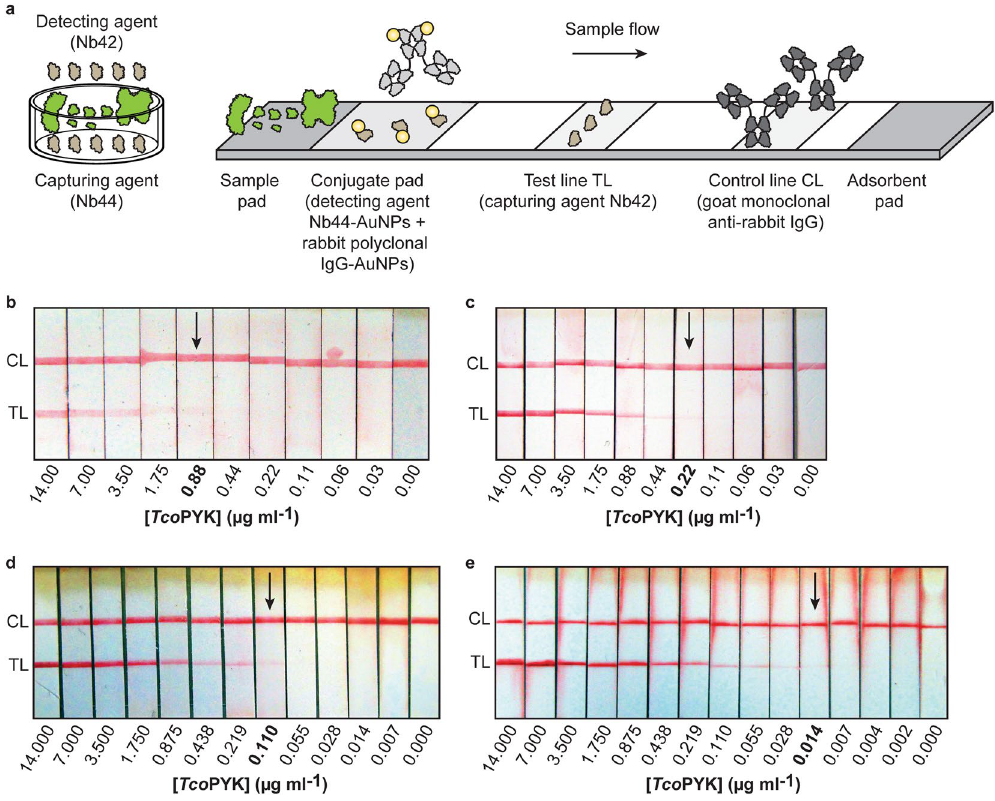
Figure 5. Generation of a Nb-based LFA for detection of T . congolense . ( a ) Schematic representation of the Nb44/Nb42 sandwich ELISA (left panel) and Nb44/Nb42 LFA (right panel). In both panels, the T . congolense antigens are coloured in green, while the Nbs are shown in brown. IgGs are displayed in light (rabbit polyclonal) and dark (goat monoclonal) grey. The AuNPs are shown as yellow circles and are not drawn to scale with the Nbs and IgGs. ( b – e ) LFA read-outs for ( b ) PBS spiked with a dilution series of Tco PYK using direct coating of Nb42 on the TL, ( c ) PBS spiked with a dilution series of Tco PYK using streptavidin-based coating of biotinylated Nb42 on the TL, ( d ) naive mouse serum spiked with a dilution series of Tco PYK (streptavidin-based coating of biotinylated Nb42 on the TL) and ( e ) naive mouse serum spiked with a dilution series of Tco PYK and diluted three-fold in PBS containing 1% methylcellulose and 1% Tween20 (streptavidin- based coating of biotinylated Nb42 on the TL). The visual LoD was established based on the last Tco PYK concentration at which a TL band could be observed (indicated by the black arrow). 50 μ l of sample was spotted onto the sample